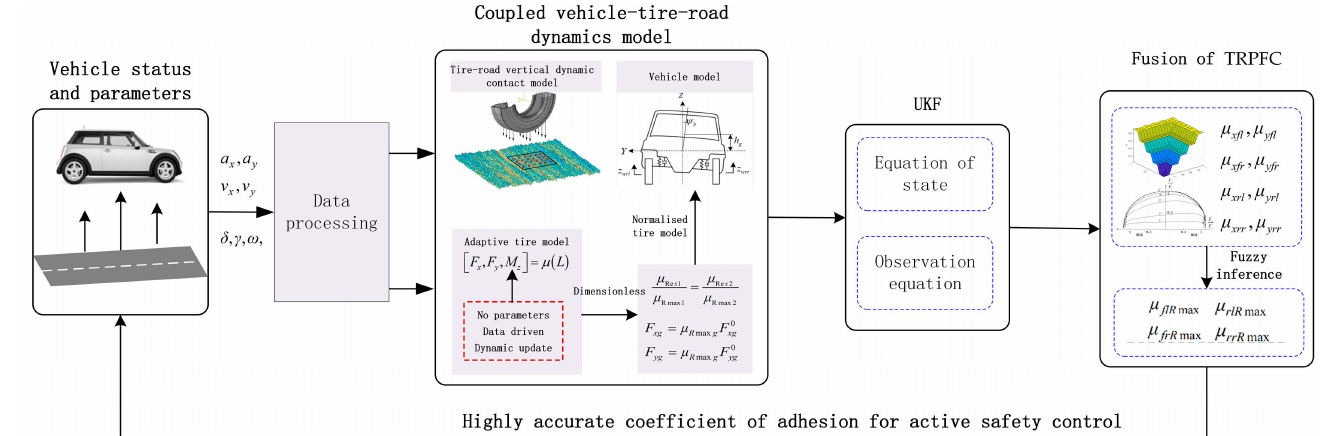
Figure 8. Flow chart for estimation of adhesion